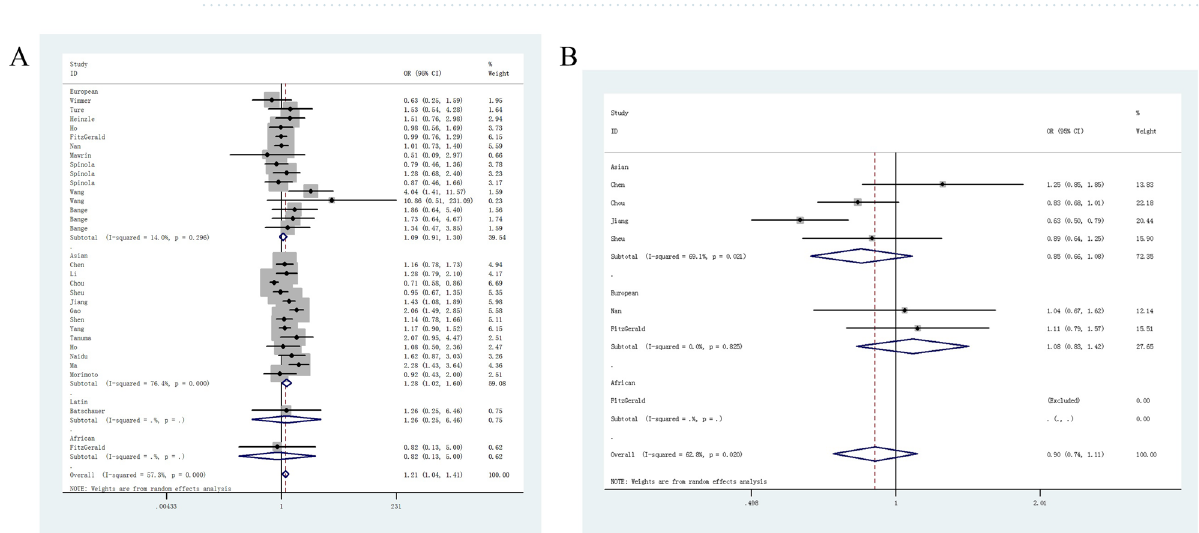
Figure 2. Forest plot of odds ratio for the association between FGFR4 G388R ( A ) and V10I ( B ) polymorphisms and susceptibility of cancer (dominant genetic model, fixed-effects) in subgroup analysis by cancer type.